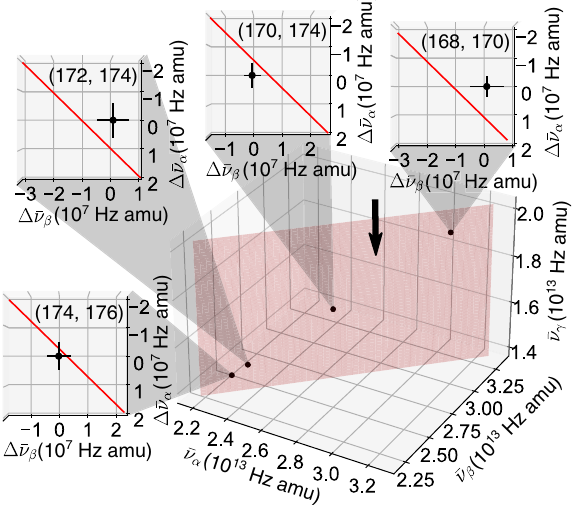
FIG. 7. Generalized King plot using all three transitions. The plane is the fit to the data by Eq. (10). Each inset shows the enlarged view magnified by 10 6 , seen from the direction parallel to the plane and orthogonal to the β axis (indicated by the arrow), and so the plane is represented as the red line in the inset. The labels Δ ¯ ν α and Δ ¯ ν β show the deviations from the modified ISs, and a label for the γ axis is not shown in the insets. Error bars represent 1 σ uncertainties.